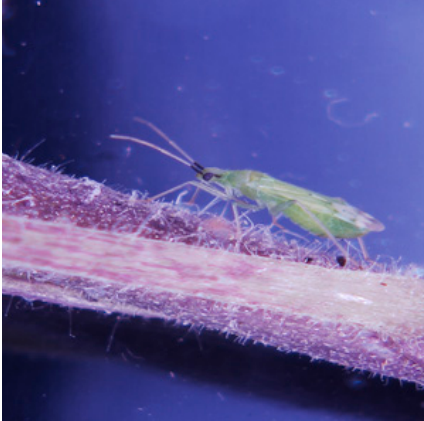
Figure 1. Adult female Macrolophus pygmaeus .